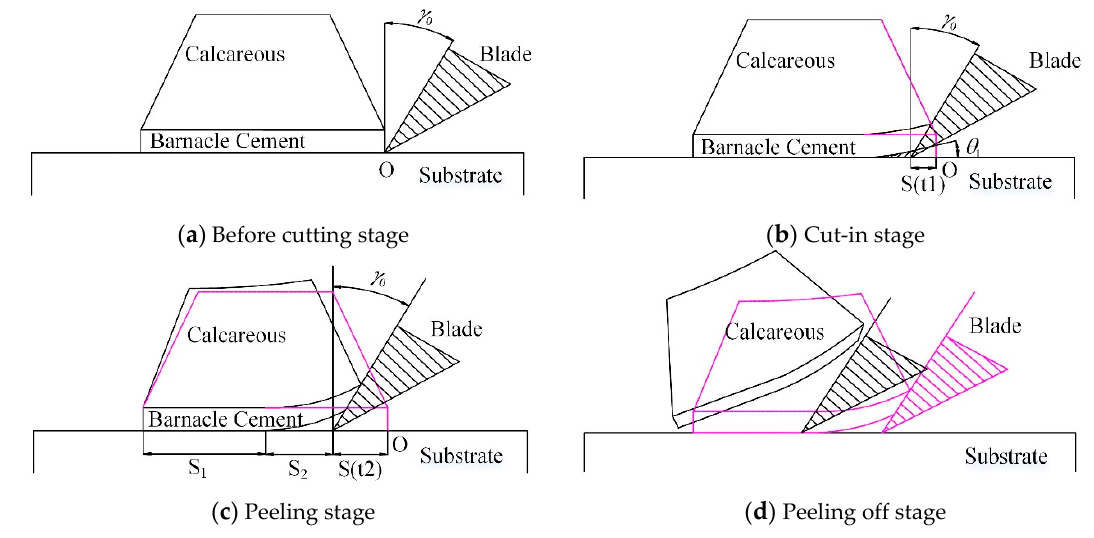
Figure 6. Schematic diagram of cleaning the barnacle process.